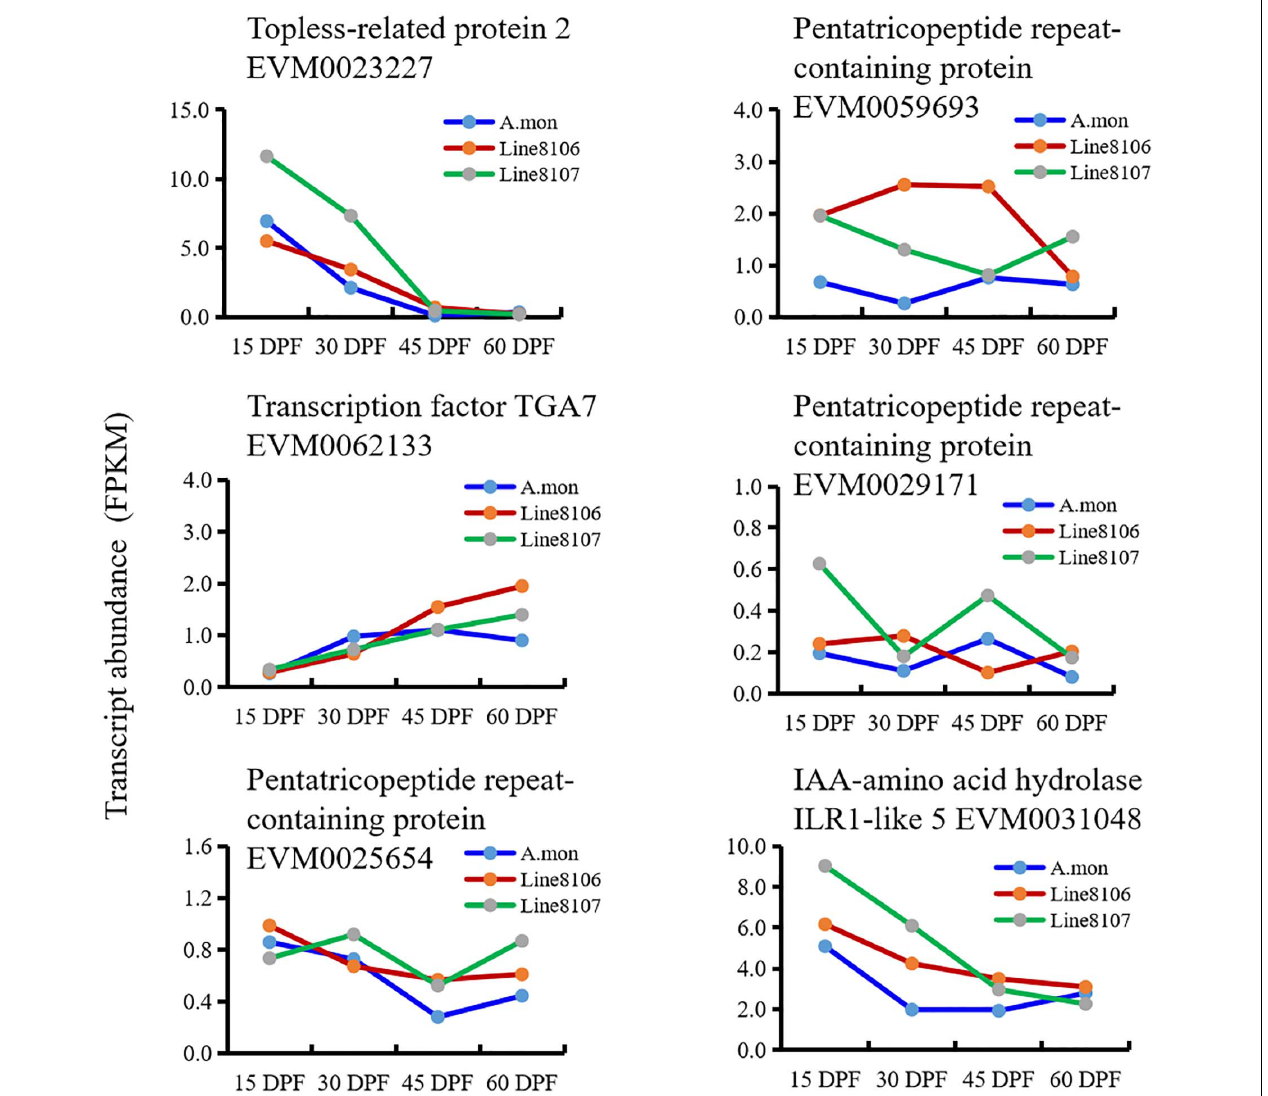
FIGURE 5 | Expression levels of identified candidate genes associated with peanut seed size/weight in A. monticola ( A. mon ), Line 8106, and Line 8107. The genes EVM0023227, EVM0062133, and EVM0031048 encode topless-related protein 2, transcription factor TGA7, and IAA-amino acid hydrolase ILR1-like 5, respectively. The other genes encode pentatricopeptide repeat-containing